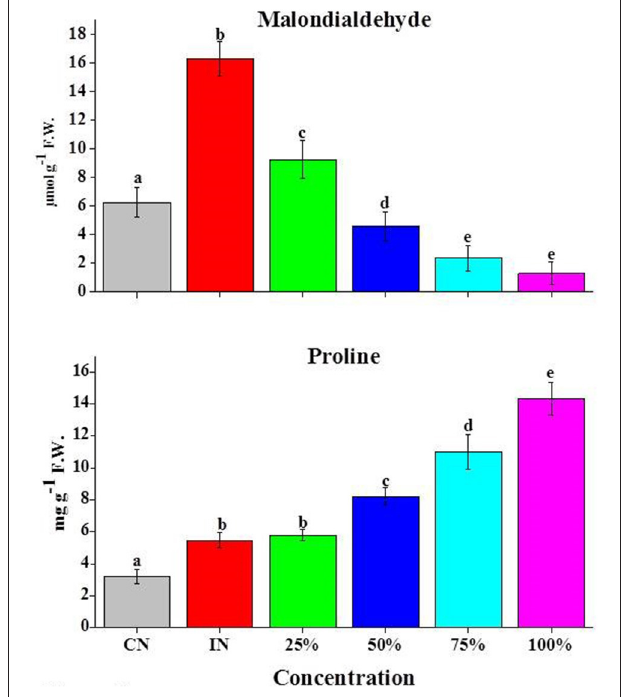
FIGURE 5 | Effects of Z. armatum DC EO on PL (mg g − 1 FW) and MDA ( µ mol g − 1 FW) contents of tomato fruits inoculated with A. alternata . CN, control; IN, inoculated; 25, 50, 75, and 100% indicate concentrations of EO used. Values represent mean ± standard error, where number of biological repeats is five ( n = 5). Different letters (a–e) indicate significant differences from each other in all combinations at p <